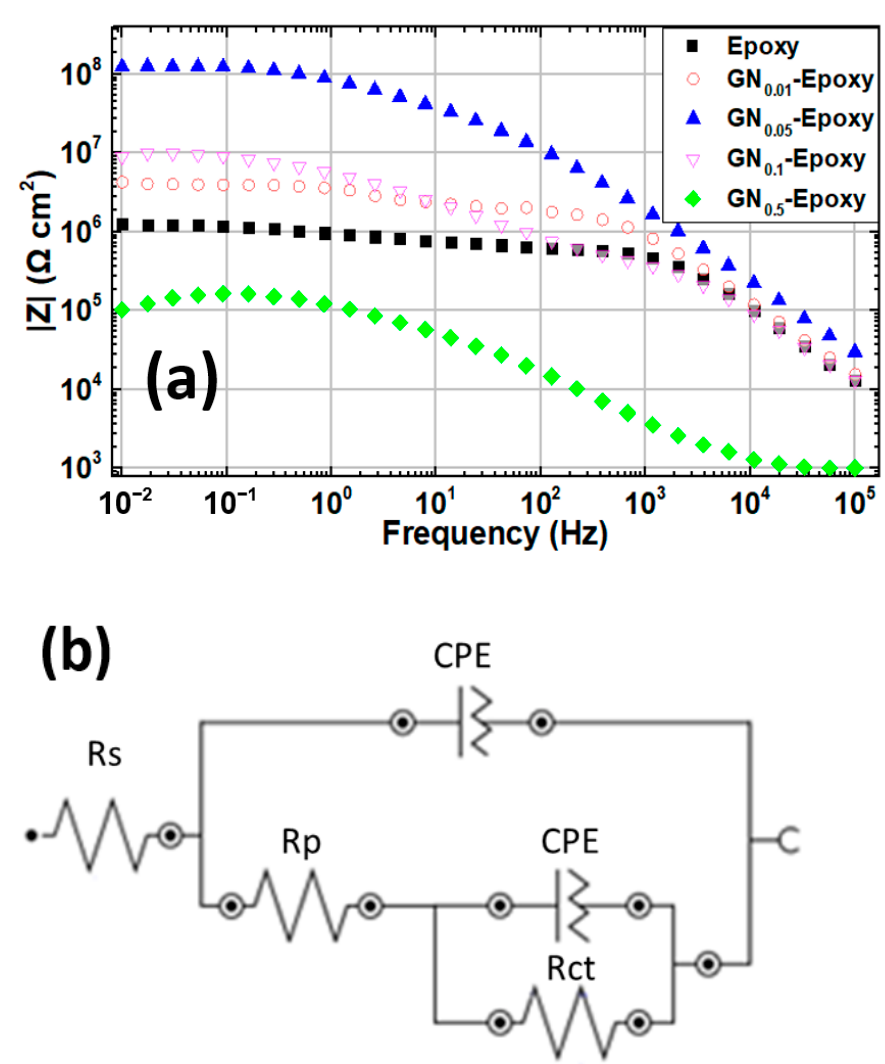
Figure 3. Nyquist plots of EIS for samples immersed in 3.5 wt.% NaCl solution. ( b , c ) are the succes- sively magnified views of ( a ).